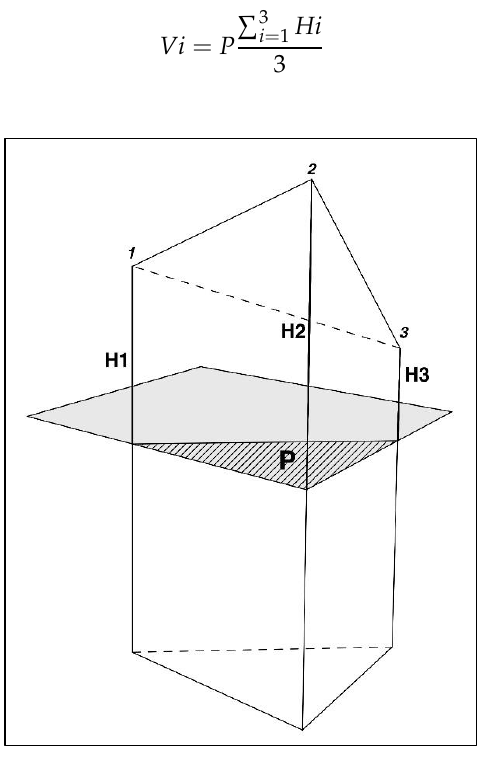
Figure 7. Elementary triangular prism.